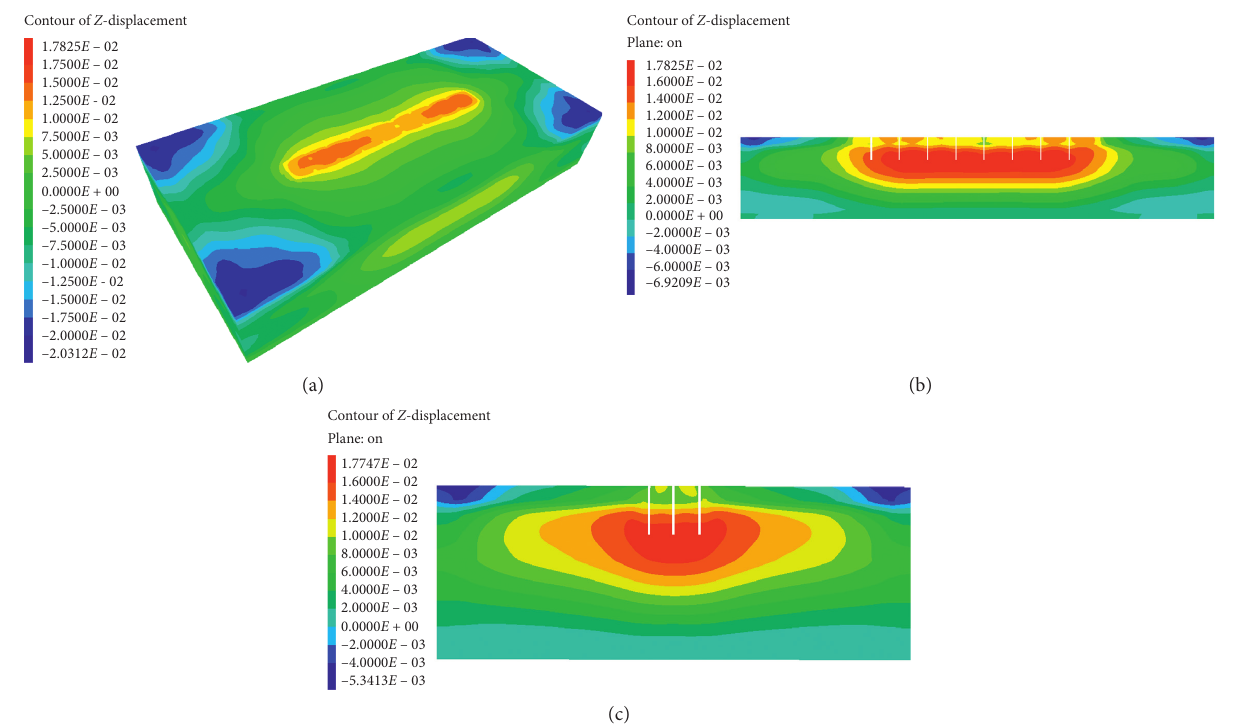
Figure 27: Group wells subsidence nephogram after the second drawdown (unit: m). (a) Three-dimensional diagram. (b) Cross section of the well midpoint. (c) Longitudinal section of the well midpoint.